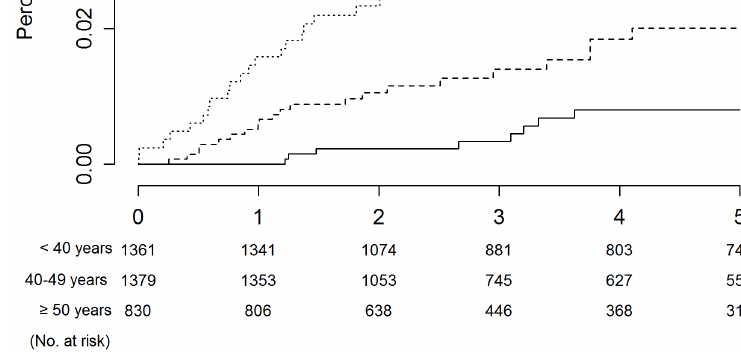
Figure 5. Cumulative probability of non-AIDS cancer by age group.